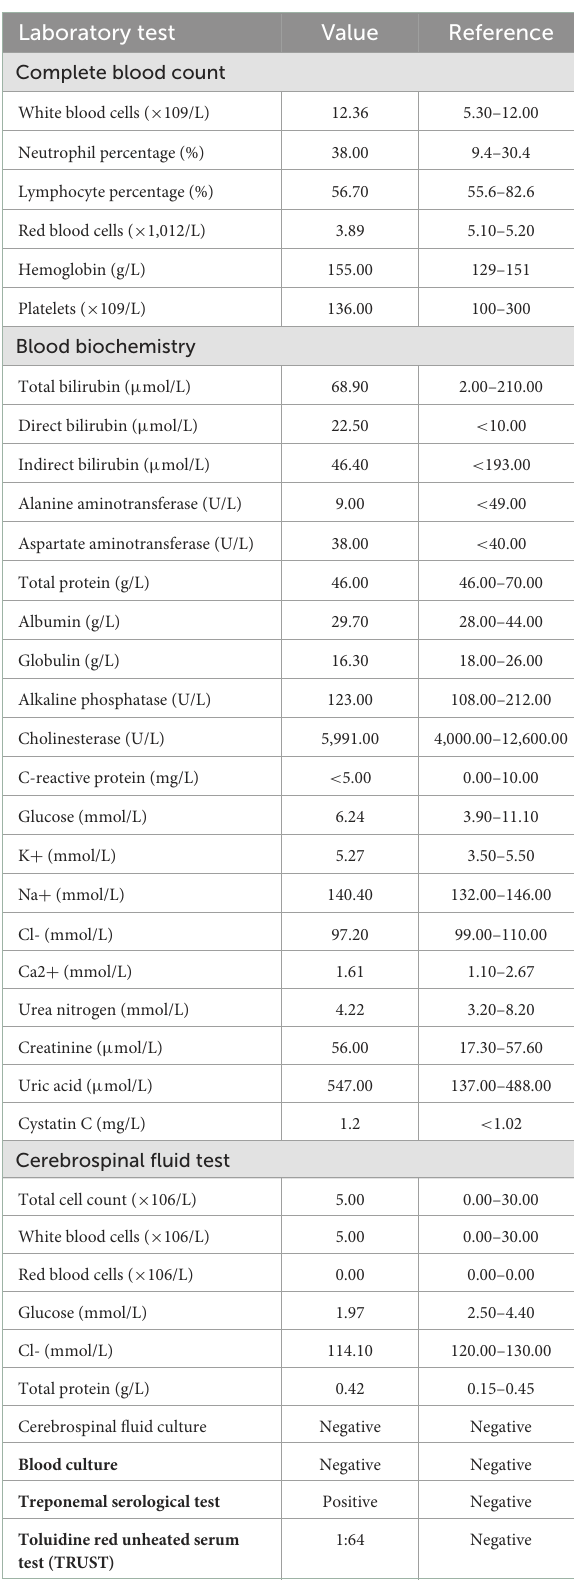
TABLE 1 Laboratory test